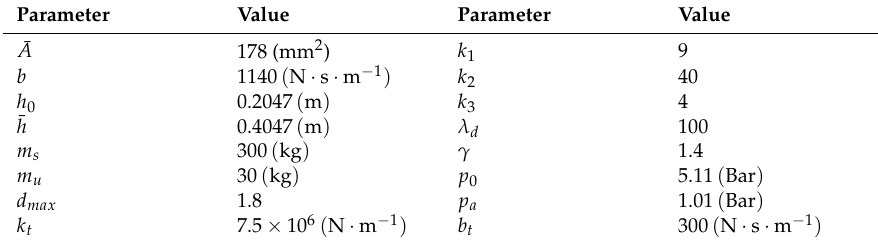
Table 2. Parameters for